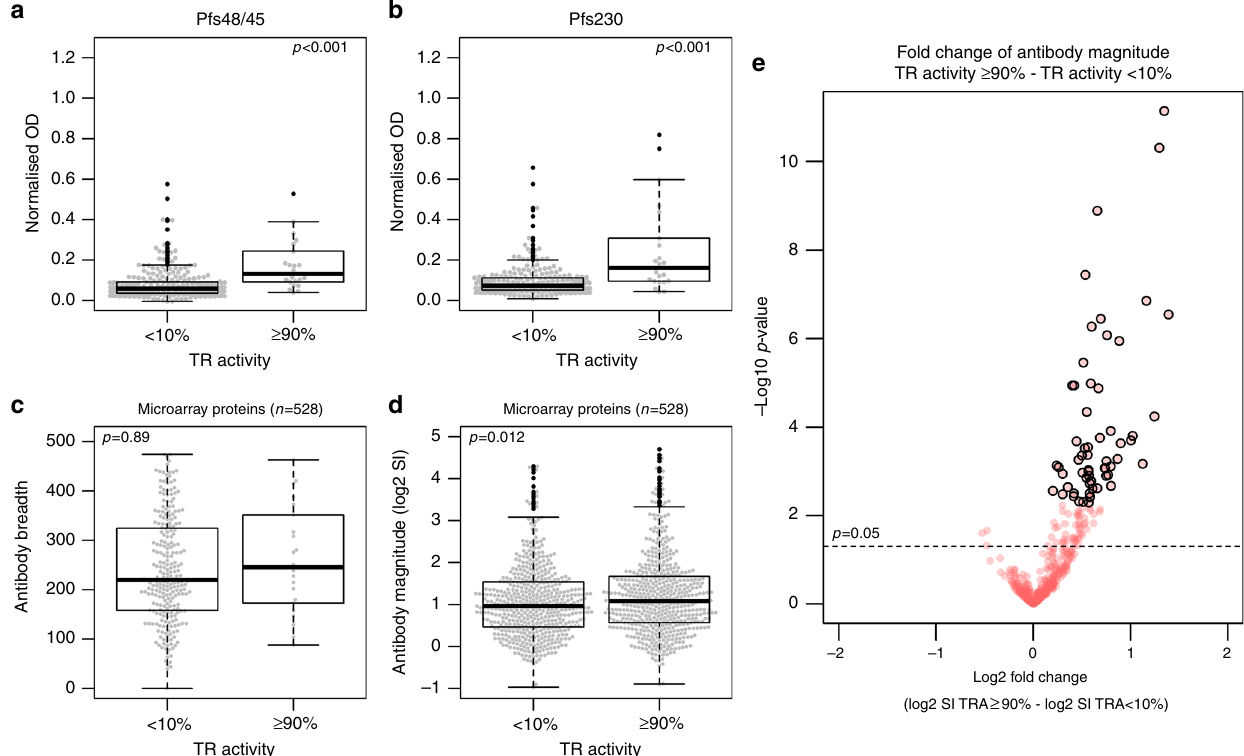
Fig. 2 Transmission-reducing activity (TRA) and antibody responses to Pfs48/45, Pfs230 and microarray proteins. TRA was categorised as described, to compare responses between gametocyte-positive individuals with < 10% TRA, and individuals with > 90% TRA. Antibody responses to correctly folded, recombinant Pfs48/45-10C and Pfs230 (230CMB) were measured using ELISA, with antibody intensity given as the ELISA optical density (OD) values (450 nm). Antibody responses to microarray proteins are given as the log 2 -transformed signal intensity (SI) minus the vehicle SI, which equates to the log 2 -fold change over this background. a , b Boxplots of α -Pfs48/45 and α -Pfs230 antibody intensity with TRA. c Responses to the microarray protein targets ( n = 528). Antibody breadth is the number of proteins reactive above background in each individual, within the given groups. d Magnitude of antibody response to microarray protein targets. Each dot represents the average SI of response to each protein target by all individuals within given groups. p- values for intensity data and response breadth are from an F- test for differences in OD/SI between all age groups, derived from linear regression, and adjusted for gametocyte density or from students t -test (for magnitude only). For all boxplots, outliers are shown in black, whereas all data points are shown in grey as a bee-swarm. e Volcano plot showing the log 2 -fold change of the mean signal intensity for TRA as de fi ned above. The p -value shown by the dotted line is unadjusted for false discovery. Black-circled data points are those that remain signi fi cant after p -values have been adjusted to control the rate of false discovery below 5%, using the Benjamini – Hochberg